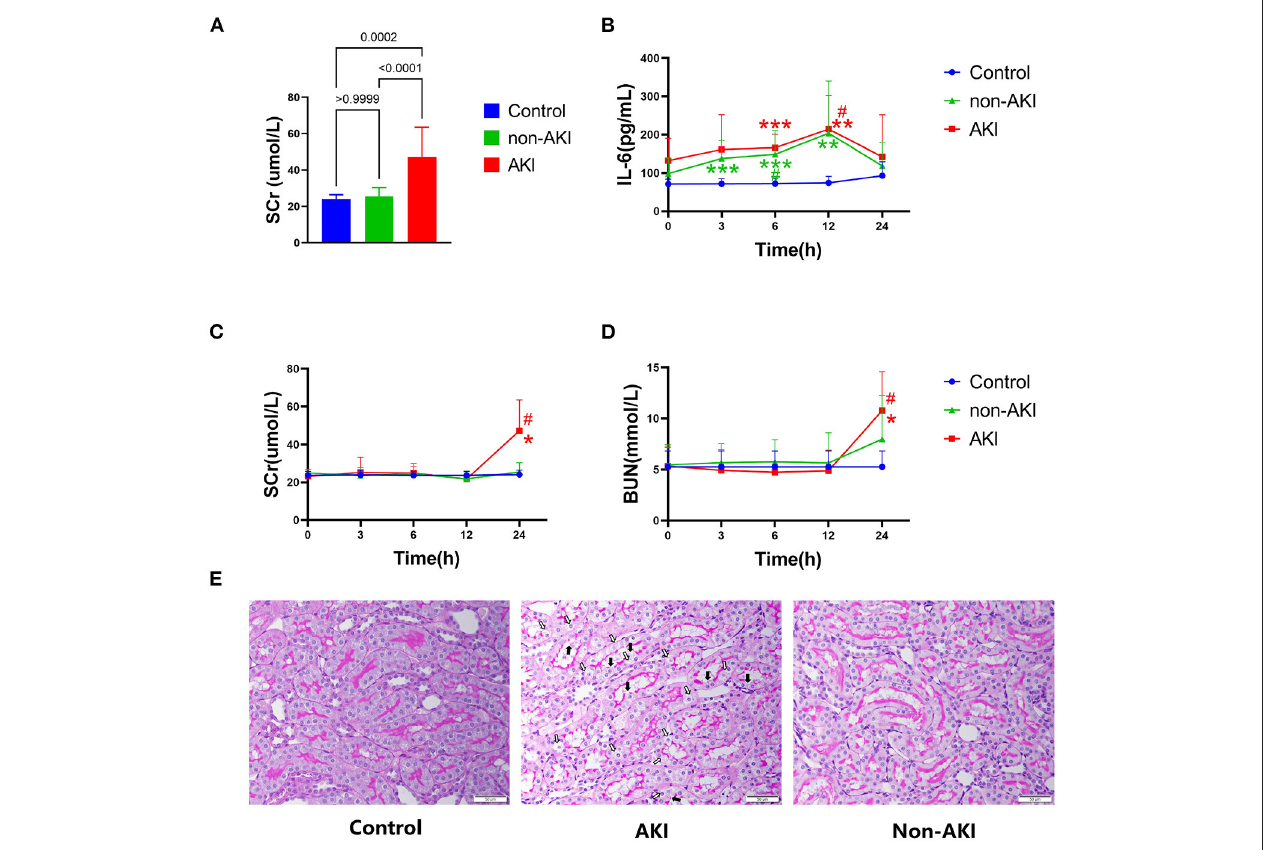
FIGURE 2 | Animal groupings (A) , systemic inflammation index (B) , renal function (C,D) , and renal pathology (E) are presented. (A) SCr at 24h of control, non-AKI, and AKI groups. CLP rats were further divided into the AKI group ( n = 8) and non-AKI group ( n = 15) based on whether the SCr at 24h ≥ 1.5 times baseline. (B) Changes in IL-6 (systemic inflammation index) at baseline, 3, 6, 12, and 24h of each group. In both AKI and non-AKI groups, the levels of IL-6 increased gradually and peaked at 12h. (C,D) Significant increases in SCr and BUN were only observed at 24h after CLP in the AKI group. ( E) Representative microscopic images of the kidney tissues stained with periodic acid-Schiff (PAS) of control group (Left), AKI group (Middle), and non-AKI group (Right) at 24h. Original magnification 400, bar 50 µ m. In the AKI group (Middle), only minor histological changes encompassing mild brush-border loss (black arrow) and vacuolization of tubular cells (white arrow) were present on kidney histology. Data are expressed as mean ± SD. P -values from one-way or two-way ANOVA are shown. * P < 0.05, ** P < 0.01, *** P < 0.001, compared to control group; # P < 0.05, compared to baseline. CLP, cecum ligation and puncture; SCr, serum creatinine; BUN, blood urea nitrogen; IL-6, interleukin-6; AKI, acute kidney